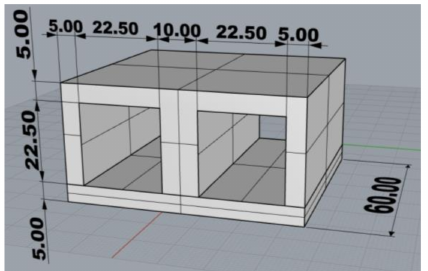
Figure 3. Drawing of the test casting (mm) (3D, Rhinoceros